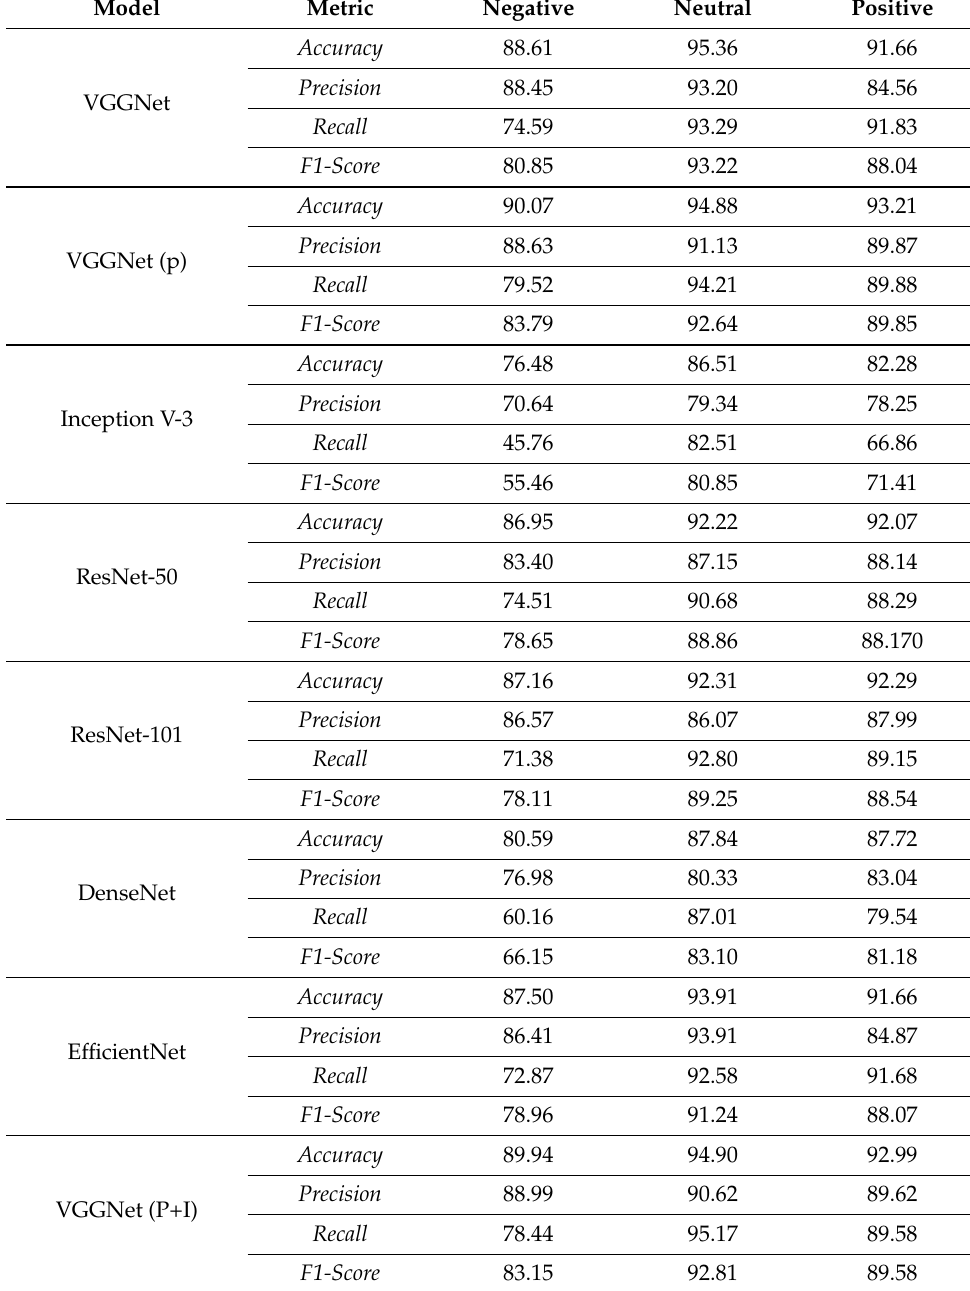
Table 9. Experimental results of the proposed visual sentiment analyzer on task 1 in terms of accuracy, precision, recall, and F1-score per class. P represents the version of the model pre-trained on the Places dataset while the rest are pre-trained on the ImageNet